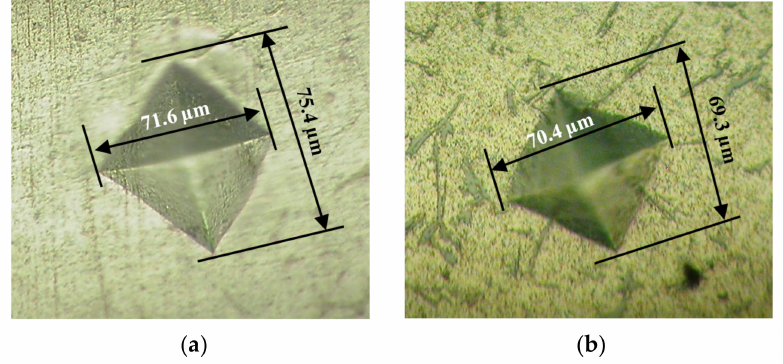
Figure 5. Microhardness indenter traces on the surfaces of ( a ) Al–1.3% Si and ( b ) Al–1.5% Si alloys to illustrate the microstructural features underneath each